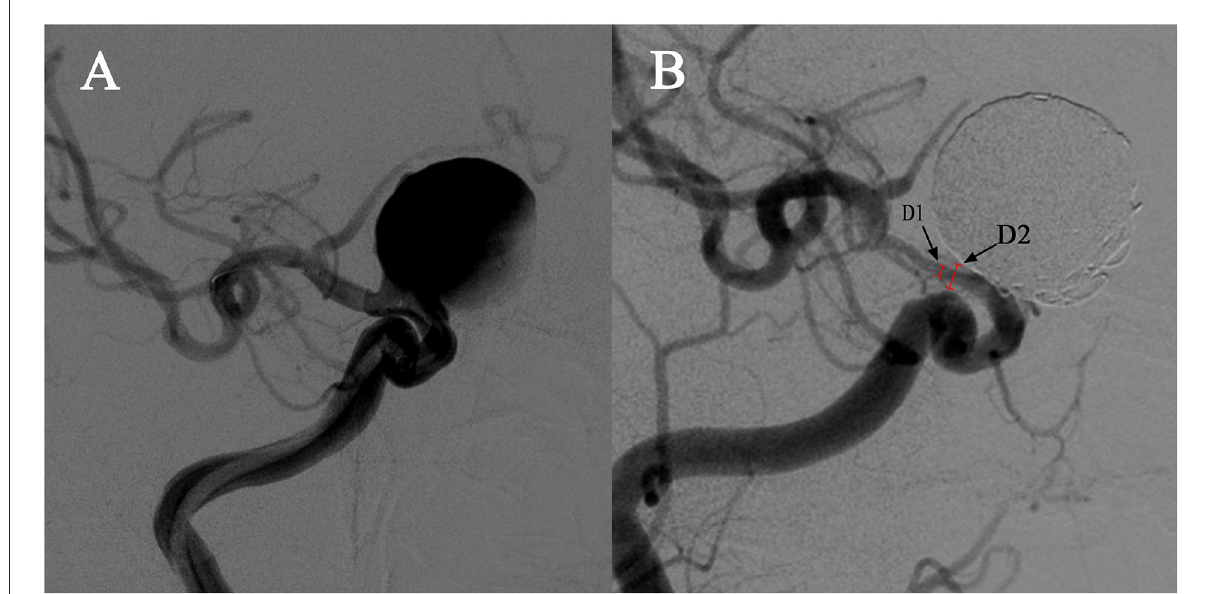
FIGURE1 Demonstration of quantitative determination of stent stenosis. (A) A case of a right carotid ophthalmic aneurysm treated with a PED stent and coiling. (B) . The follow-up angiography showed in-stent stenosis at the distal end of the stent. D1 is the narrowest vessel diameter and D2 is the stent diameter in the same position confirmed by the mask image. The stenosis was calculated as follows: 1 – [D2/D1] × 100%.